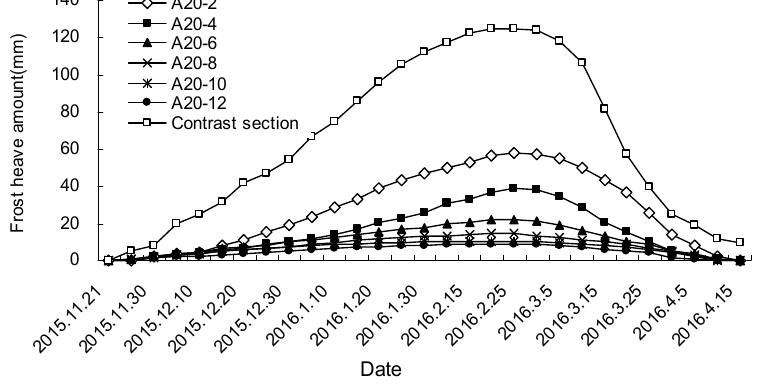
Figure 2. Change process lines of the frost heave amounts using different EPS treatments.